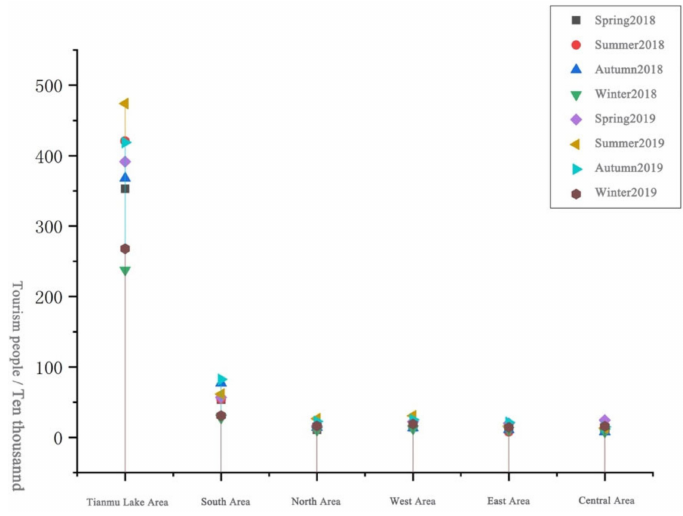
Figure 10. Seasonal distribution characteristics of regional tourism flows.